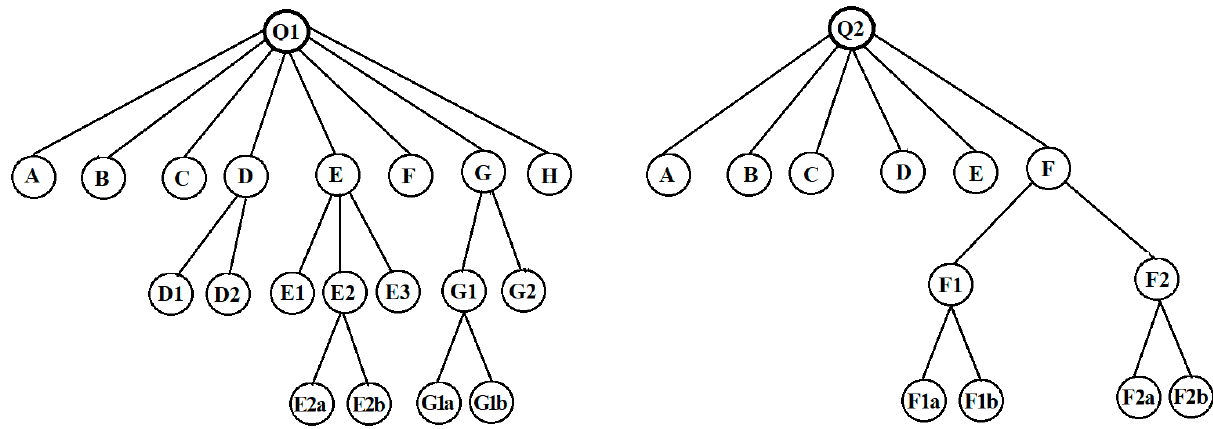
Figure 2. Concept maps (tree diagrams) showing the structure of the concepts and sub-concepts that have emerged from the content analysis of participants’ responses to questions Q 1 and Q 2 .